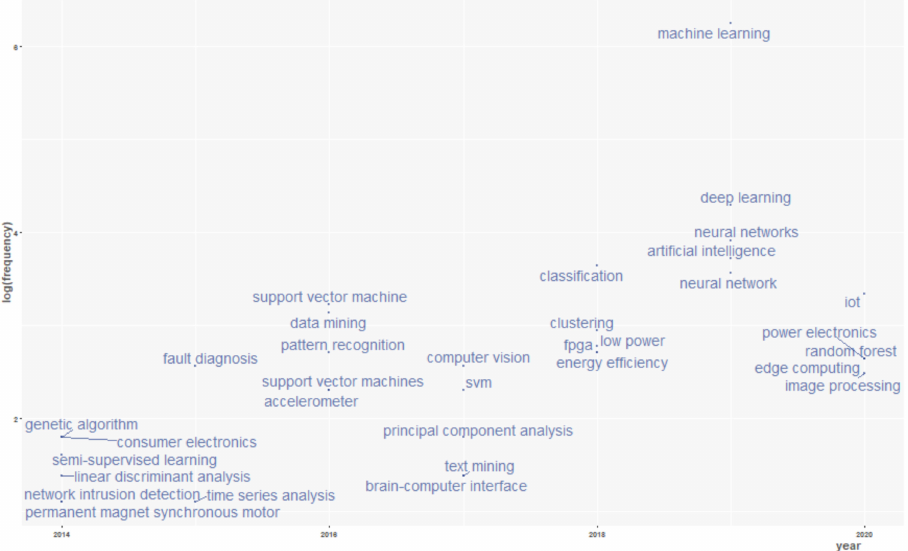
Figure 7. Trending topics according to